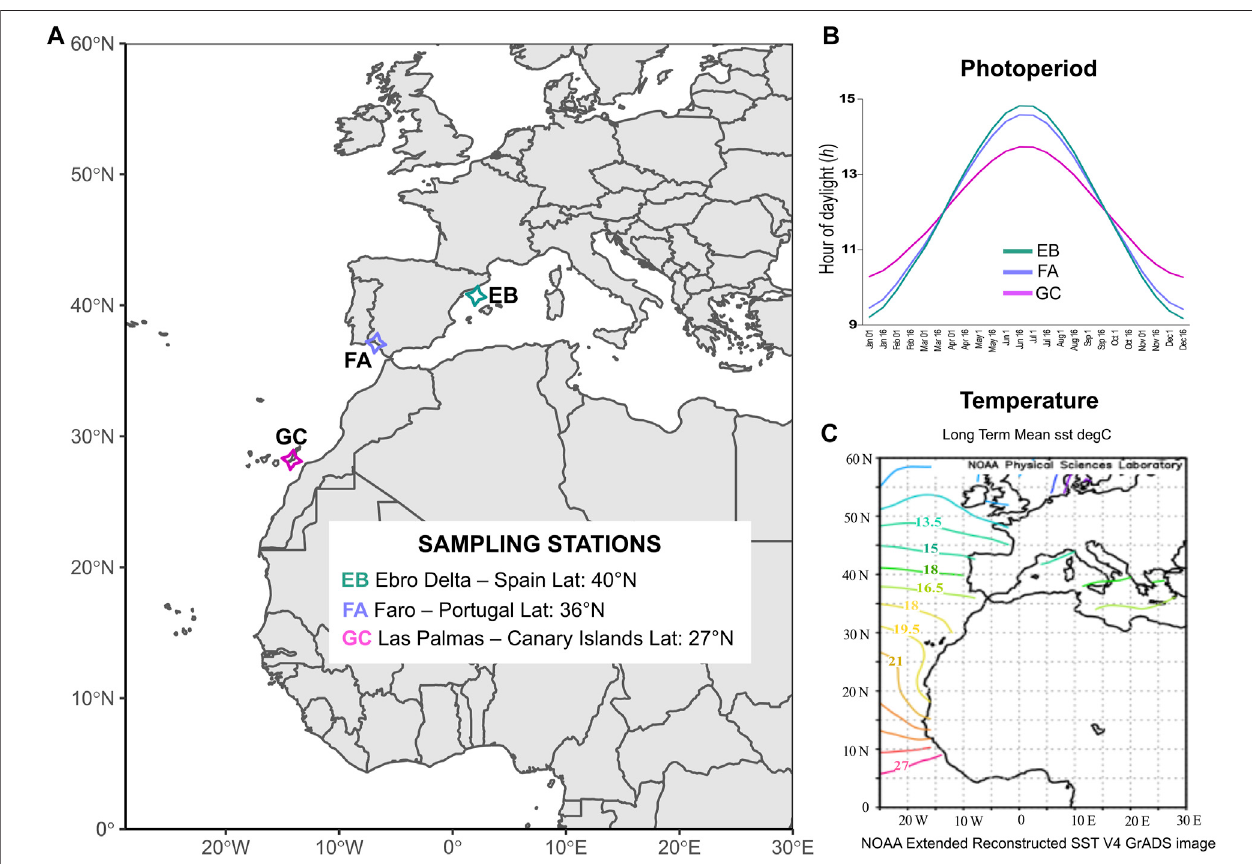
FIGURE1| Samplingschemeandenvironmentalcharacteristicsoftheselectedsites. (A) Samplinglocationsof C.nodosa :GC — LasPalmasdeGranCanaria(Lat: 27 ° N, Canary Islands); FA — Faro (Lat: 36 ° N, Portugal); EB — Ebro Delta (Lat: 40 ° N, Spain). (B) Annual patterns of photoperiod for the different sampling sites. Daylight hourswerederivedfromannualdataandaveragedforevery15 days(https://www.timeanddate.com). (C) LongtermmonthlymeansofSeaSurfaceTemperature(SST) registered on the Atlantic and Mediterranean waters from NOAA derived from data for years 1971 – 2000 (https://psl.noaa.gov/data/gridded/data.noaa.ersst.v4.